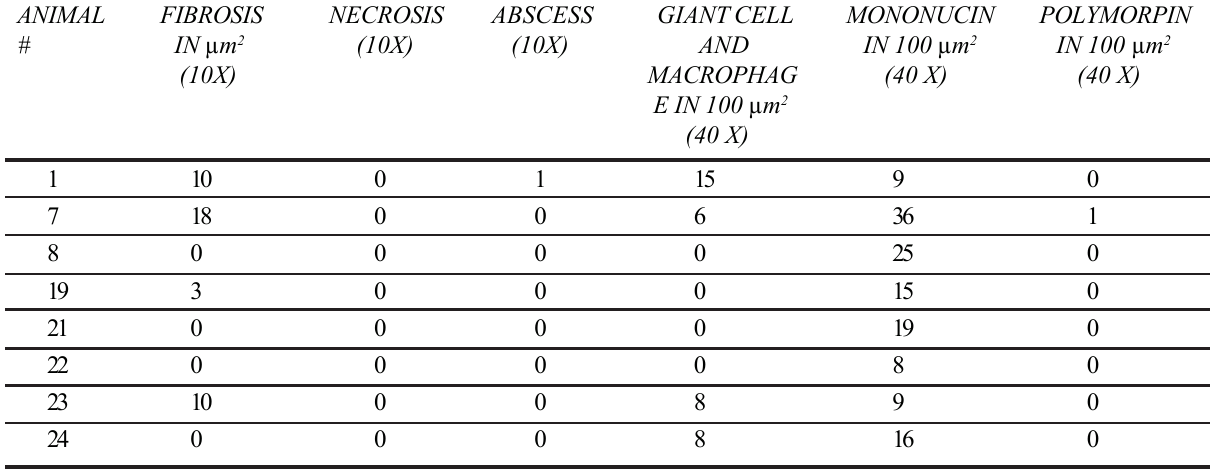
TABLE 3 - Mean of measure and counting of microscopic findings in cohort C-A, in three different cuts of the same specimen, under 10 and 40x magnification, carried out by two different observers ANIMAL